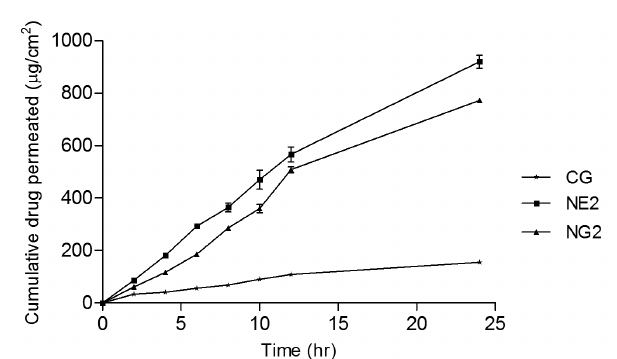
FIGURE 5 - Graphic representation of cumulative drug release for CG, NE2 and NG2.